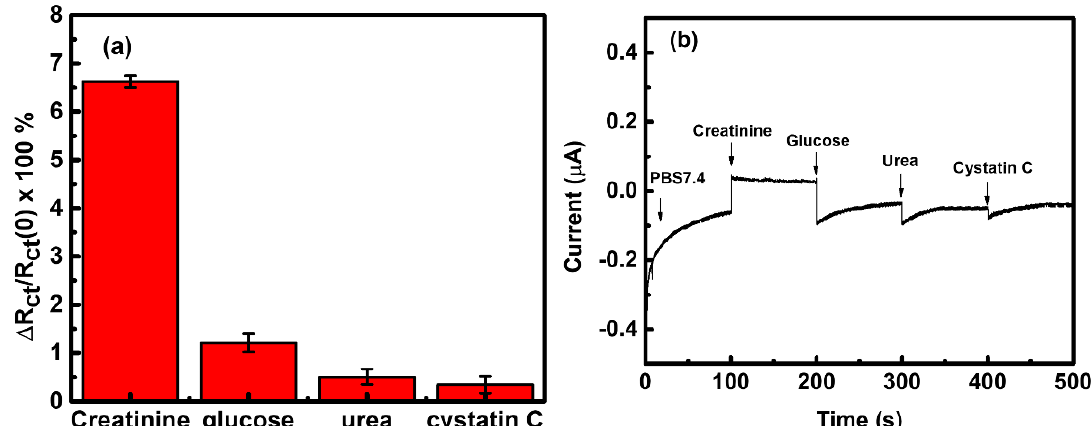
Figure 9. ( a ) Selectivity analysis of ZIF-8 NPs/PEDOT:PSS/ITO sensing electrode for creatinine com- pared to glucose (3 mM), urea (5 mM), and cystatin C (2 mM) ( b ) Chronoamperometric characteri-